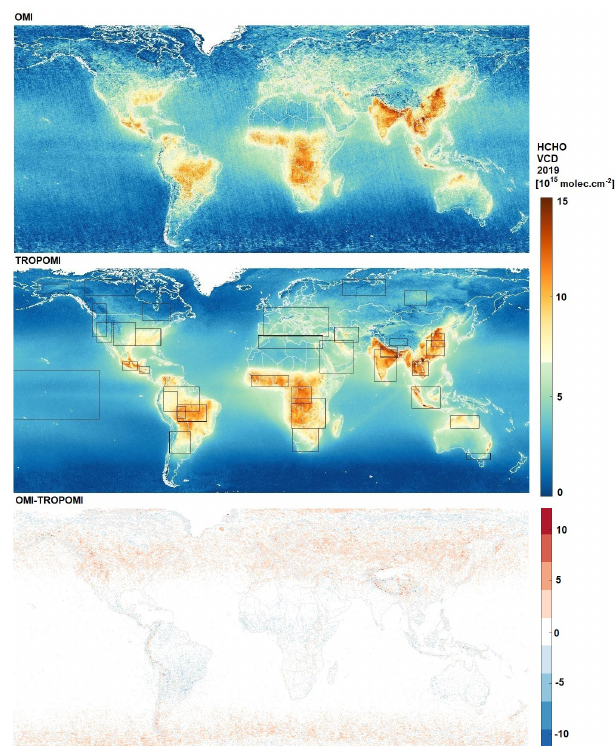
Figure 5. Average HCHO tropospheric column ( N v_clear ) retrieved from OMI (first line) and TROPOMI (second line) in 2019. Lim- its of the regions selected for the comparisons are shown on the TROPOMI map. Differences between OMI and TROPOMI maps are shown on the last panel. The same grid is used for both datasets (0.05 ◦ ). Data are filtered using the product quality flags. The large black boxes on the TROPOMI maps represent the regions used in the comparisons (see Figs. 6 and